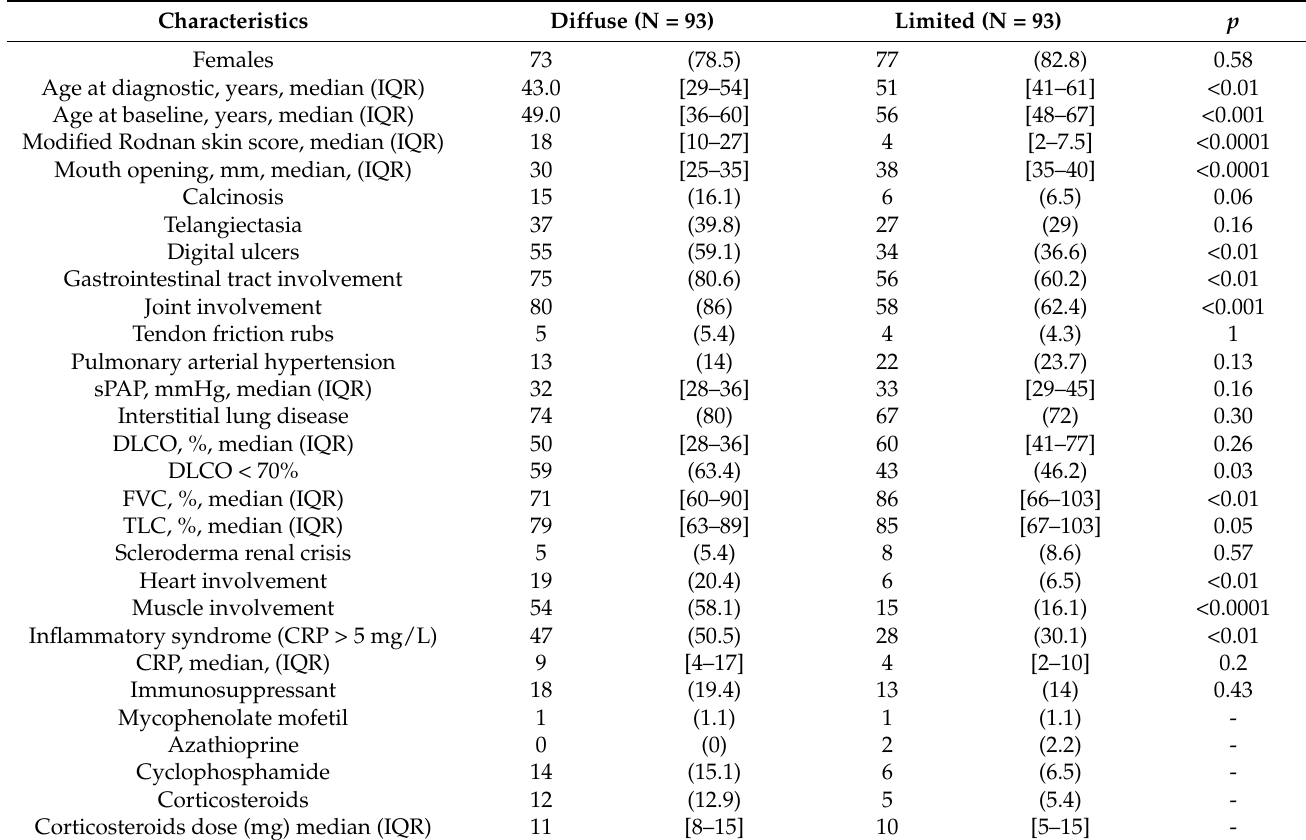
Table 3. Characteristics of patients with anti-topoisomerase 1 antibodies